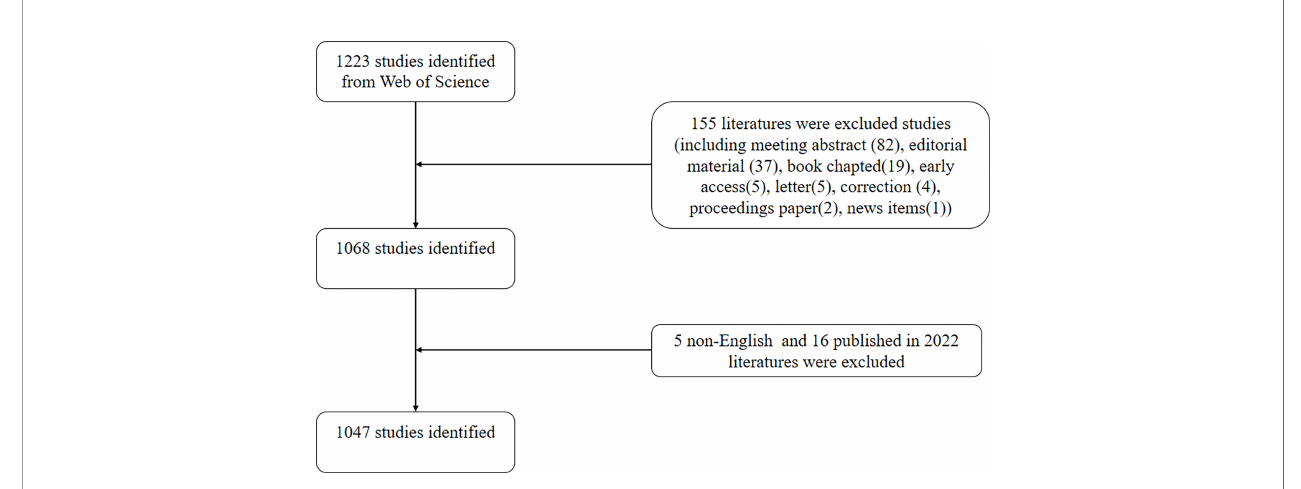
FIGURE 1 | Flowchart of the screening